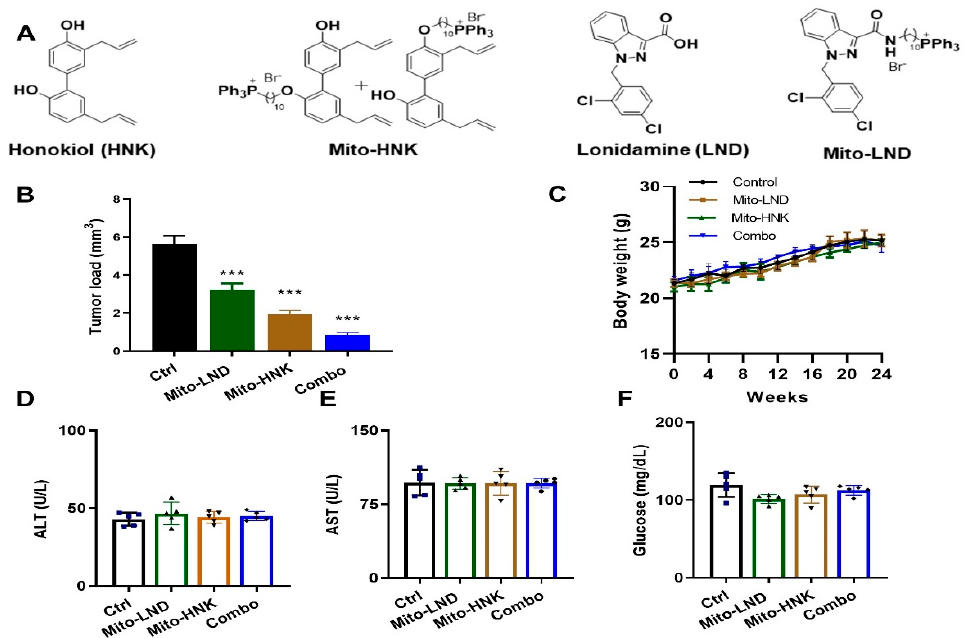
Figure 1. Efficacy of Mito-HNK, Mito-LND, and their combination in the B[ a ]P-induced lung cancer model . ( A ) Structures of HNK, Mito-HNK, LND, and Mito-LND. ( B ) Efficacy on tumor load. ( C ) Body weights. ( D – F ) Plasma levels of liver enzymes and glucose ( n = 5). Data are presented as mean ± SEM; *** p < 0.001.